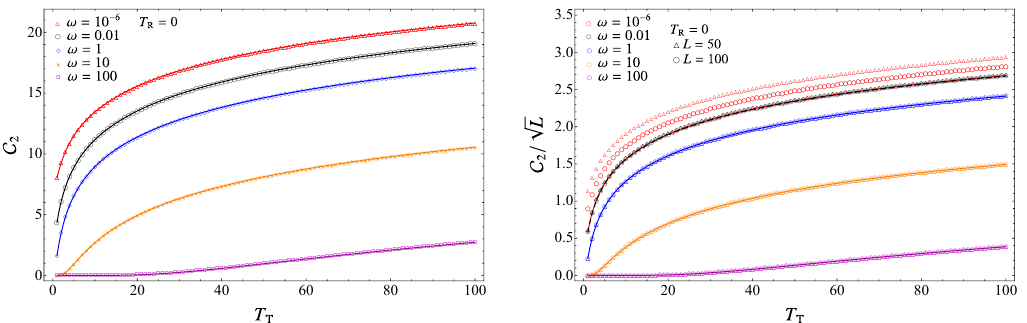
Figure 7 . The complexity C 2 for thermal states when T L = 50 as function of T to (9.43). Right panel: C 2 / of L . The solid lines correspond to (9.52). The dashed black line and the solid red line are collapsed on the curve